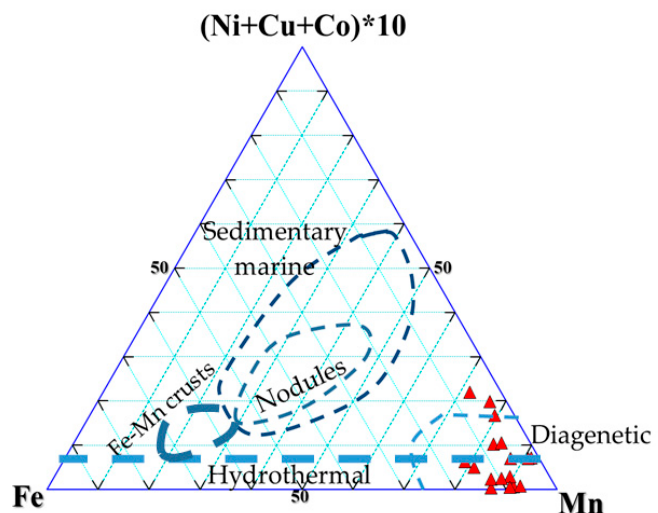
Figure 2. Mn-Fe-(Ni + Cu + Co)*10 ternary geochemical classification diagram for discrimination of Mn oxides of marine hydrogenetic, Fe-Mn crust / nodule, diagenetic and hydrothermal origin. Fields after Bonatti et al. (1972) [68], Conly et al. (2011) [69], and Polgari et al. (2012) [37]. Red triangles denote MnMISS data points. Results for Cape Vani Mn oxides indicate a mixed hydrothermal and diagenetic affinity. Note that very few samples fall outside any of the outlined fields, indicating a trend to more diverse origins (see text for discussion).